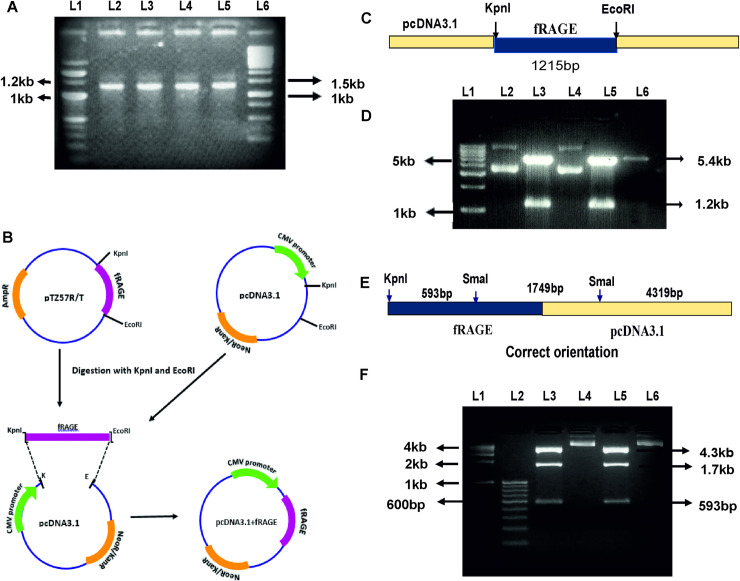
PCR amplification and cloning of RAGE gene.A) PCR product of amplified fRAGE gene. L1 -100bp marker; Lane 2–5 annealing temperature 69–72°C; L6 -1Kb marker. B) Schematic representation of recombinant pcDNA3.1 vector with fRAGE construct. The PCR product were cloned into pTZ57R/T vector. The pTZ57R/T fRAGE contract and pcDNA3.1vector was restriction digested using KpnI and EcoRI and fragment was then inserted into pcDNA3.1 vector under the control of CMV promoter. C) Schematic representation of restriction pattern of recombinant pcDNA3.1 harbouring fRAGE gene. D) Restriction digestion of recombinant pcDNA3.1 construct with KpnI and EcoRI were electrophoresed in a 1% agarose gel. L1- 1kb DNA ladder, L2- pcDNA3.1 with WT RAGE (undigested), L3- pcDNA3.1 with WT RAGE (digested), L4- pcDNA3.1 with mutant RAGE (undigested), L5- pcDNA3.1 with mutant RAGE (digested), L6—pcDNA3.1 vector (digested). Band size of 1.2kb shown in lane 3 & 5 indicates the presence of RAGE gene in recombinant pcDNA3.1 respectively. E) Schematic representation of orientation-based restriction pattern of recombinant RAGE gene in pcDNA3.1 vector. F) To confirm orientation of cloned RAGE gene recombinant pcDNA3.1 construct was restricted with KpnI and SmaI and digested products were electrophoresed in a 2% agarose gel. L1- 1kb DNA step ladder, L2- 100bp DNA ladder, L3- recombinant WT RAGE pcDNA3.1 (digested), L4- recombinant WT RAGE pcDNA3.1 (undigested), L5- recombinant mutant RAGE pcDNA3.1 (digested), L6- recombinant mutant RAGE pcDNA3.1 (undigested). Band size of 593bp, 1750bp, 4272bp shown in lane 3 & 5 indicates the correct orientation of WT RAGE and mutant RAGE gene respectively in recombinant pcDNA3.1.